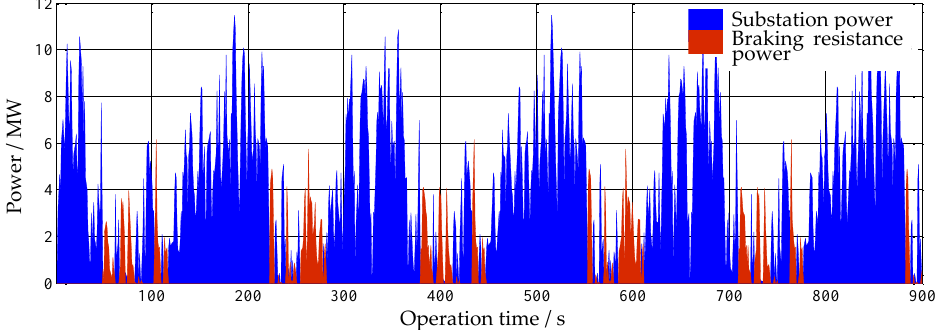
Figure 15. Total output power of traction substation and absorption power of braking resistance before dwell time optimization.